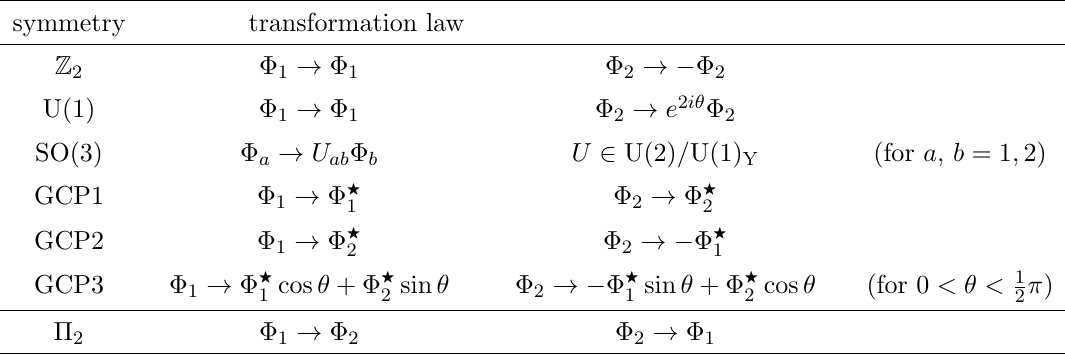
Table 1 . Possible symmetries of the 2HDM scalar potential that are respected by the SU(2) gauge kinetic terms of the scalar (cid:12)elds. The corresponding symmetry transformation laws are given in a basis where the symmetry is manifest. Note that a scalar potential that is invariant under the mirror discrete symmetry, (cid:5) 2 , is also invariant under the Z 2 in another scalar (cid:12)eld basis [20].